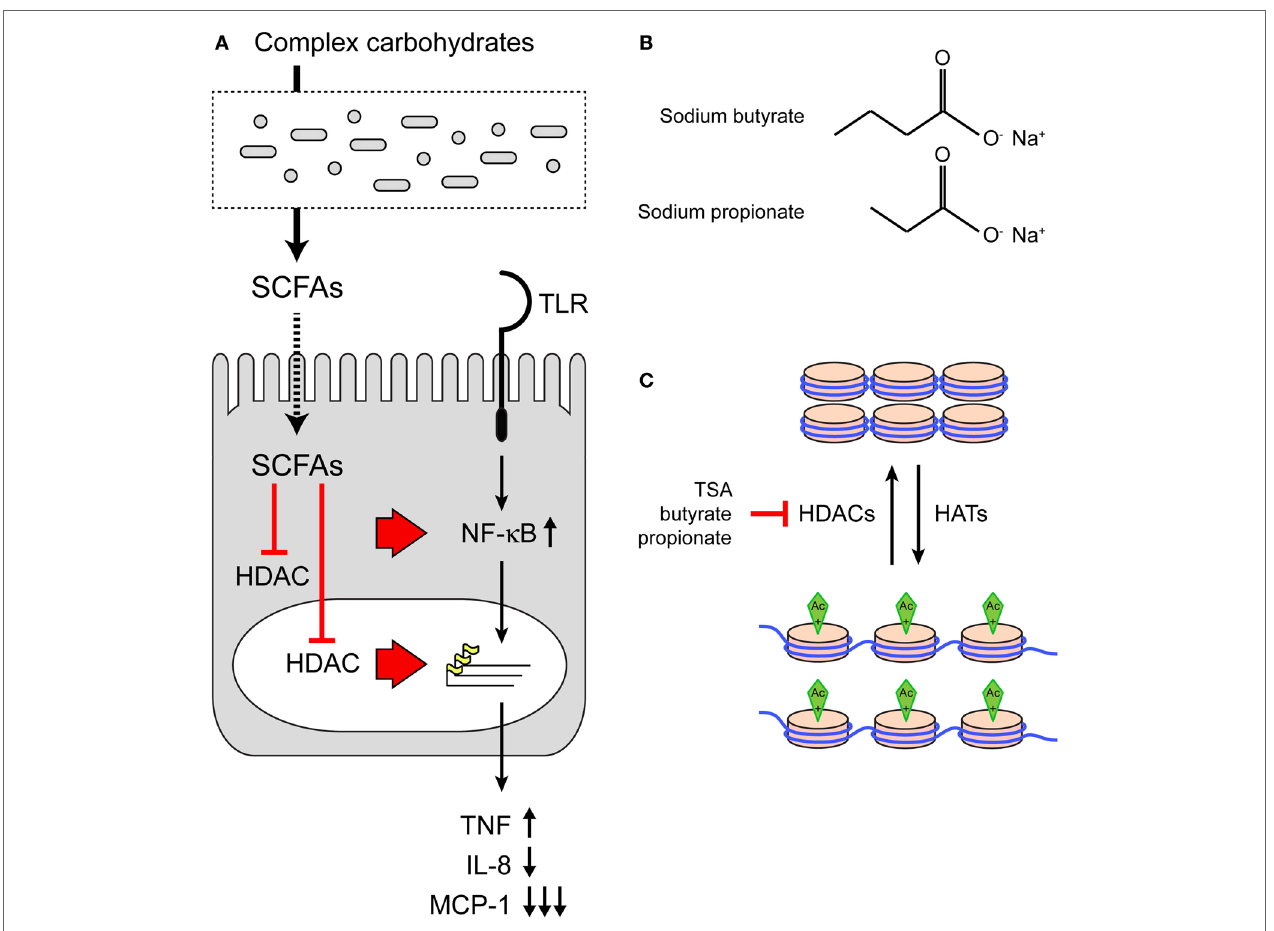
FigUre 5 | The effect of scFas on hDacs and Tlr responses. (a) Model of immunomodulation of host epithelial cells by bacterial SCFAs. SCFAs are produced by microbiota from complex carbohydrates. SCFAs can inhibit HDACs in the cytosol or nucleus. Inhibition of HDACs leads to increased acetylation of histones and changes in DNA transcription. In addition, HDAC inhibition may directly impact the NF- κ B pathway as the p65 subunit is also regulated by acetylation. (B) Structures of SCFAs sodium butyrate and sodium propionate. (c) The effect of SCFA on histone acetylation and chromatin structure. Top: DNA and histones in a closed chromatin structure with low levels of transcription. Acetylation by histone acetyl transferases (HATs) induces a open chromatin structure and active transcription (bottom). Histone deacetylases remove acetyl groups. Inhibition of HDACs by SCFAs leaves chromatin in the open, transcriptionally active